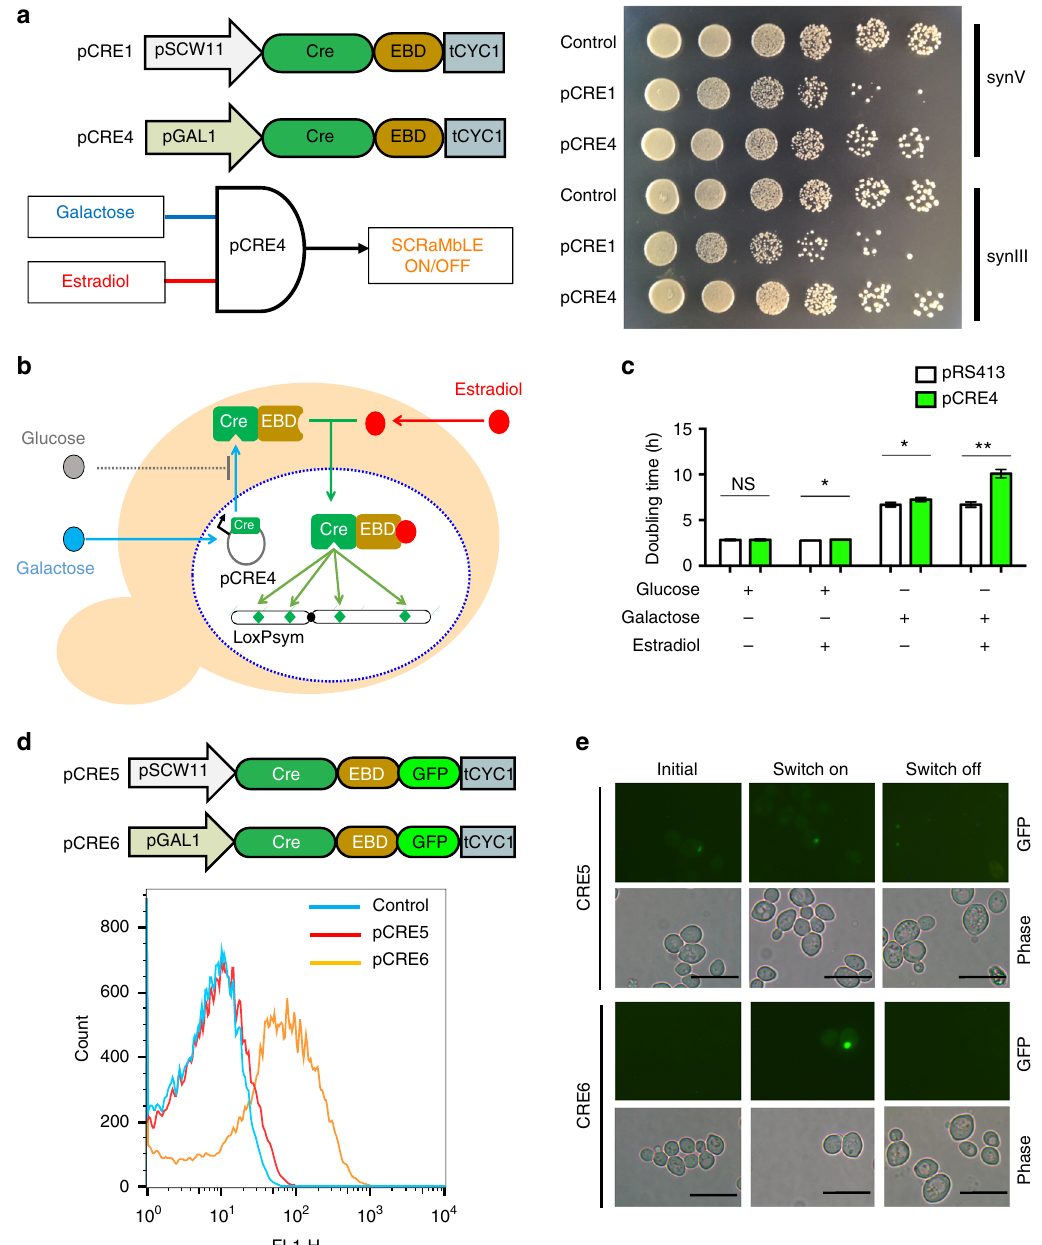
Fig. 1 Design of the “ AND gate ” switch for precise control of SCRaMbLE. a Design of the AND gate for SCRaMbLE and fi tness assays in synV yeast and synIII yeast, respectively. Activation of the “ AND gate ” pCRE4 required the input of galactose and estradiol simultaneously. Fitness assays of synV yeast and synIII yeast containing pCRE1, pCRE4, and control vector (pRS413) separately. Strain growth was assessed at 30 °C on SC-His medium. Shown here are 10-fold serial dilutions after 2 d growth. b Transcriptional regulation and cellular localization regulation of Cre recombinase for tight control of SCRaMbLE. pCRE4 was activated by induction with galactose and estradiol. c Comparison of the growth of synV strains containing pCRE4 and pRS413 under four conditions as follows: (1) SC-His glucose medium without estradiol, (2) SC-His glucose medium with 1 μ M estradiol, (3) SGal-His galactose medium without estradiol, and (4) SGal-His galactose medium with 1 μ M estradiol. (Student ’ s t -test; NS, not signi fi cant; * P ≤ 0.05, ** P ≤ 0.001). Error bars represent SD from three independent experiments. d Flow-cytometric assay expression level of Cre-EBD fusing GFPmut3b (488 nm excitation, 520nm emission). Blue curves show fl uorescence measurement of cells containing plasmids pRS413 incubated in SC-His glucose medium. Red curves show fl uorescence measurement of cells containing plasmids pCRE5 incubated in SC-His glucose medium with 1 μ M estradiol. Orange curves show fl uorescence measurement of cells containing plasmids pCRE6 in SGal-His medium with 1 μ M estradiol. e The “ switch on ” media for CRE5 and CRE6 were SC-His medium containing 1 µ M estradiol and SGal-His medium containing 1 µ M estradiol, respectively. The “ initial state ” and the “ switch off ” media were SC-His medium. The GFP fl uorescence of the cells were imaged from this cell lawn using a fl uorescence microscope (Olympus CX41). Scale bars, 10 µ